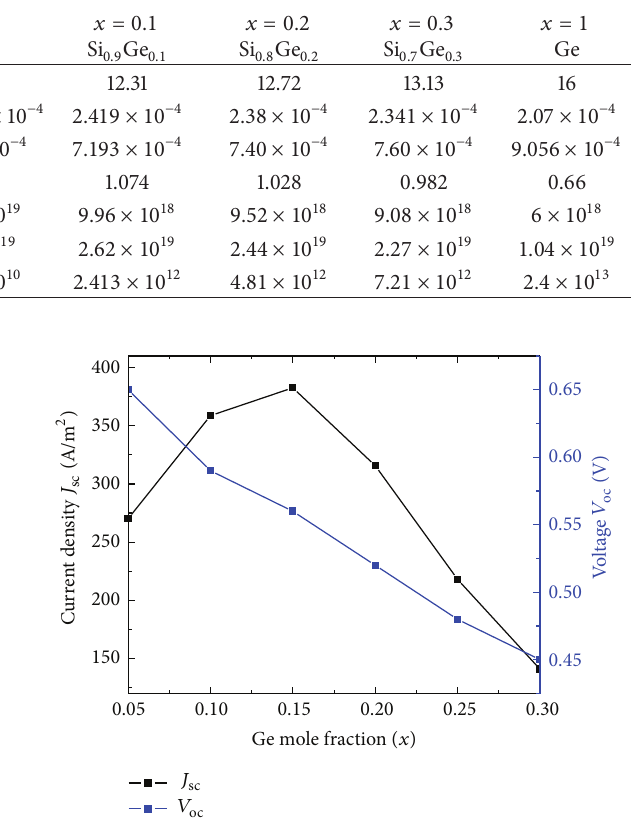
in the SiGe solar cells with different Ge